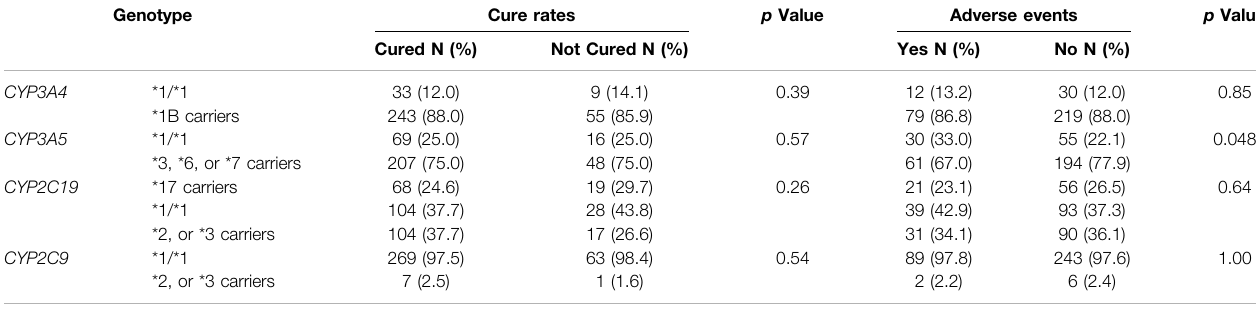
TABLE 4 | Association of genotype with praziquantel ef fi cacy (cure rates) and treatment-associated adverse events. Genotype